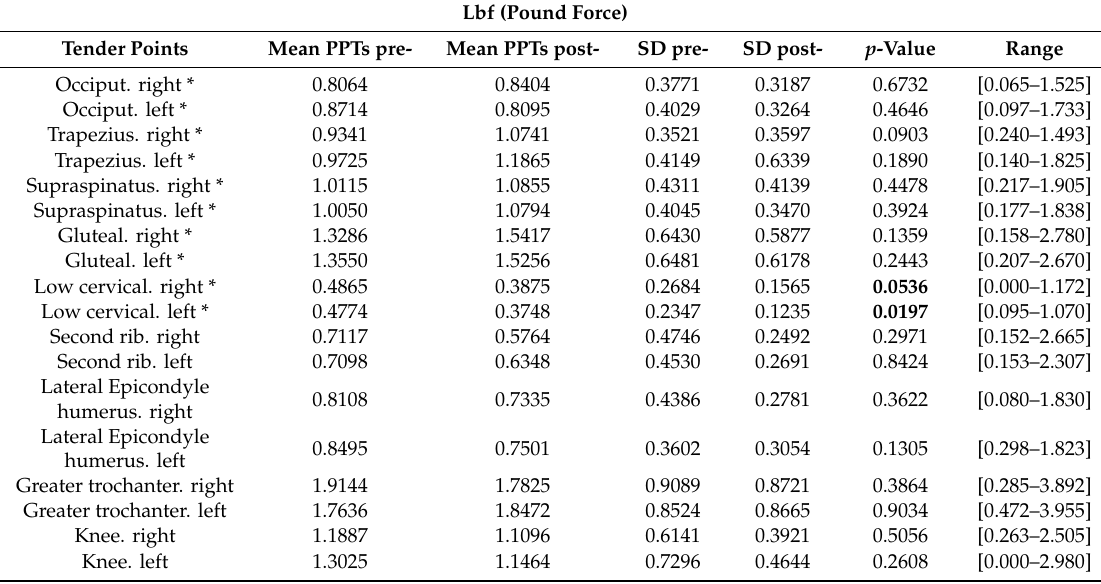
Table 2. Patient tender point sensitivity assessment, as determined by triplicate measurements in lbf with a FDIX Force Gage, ForceOne algometer (Wagner Instruments, Greenwich, CT, USA) at baseline ( n =